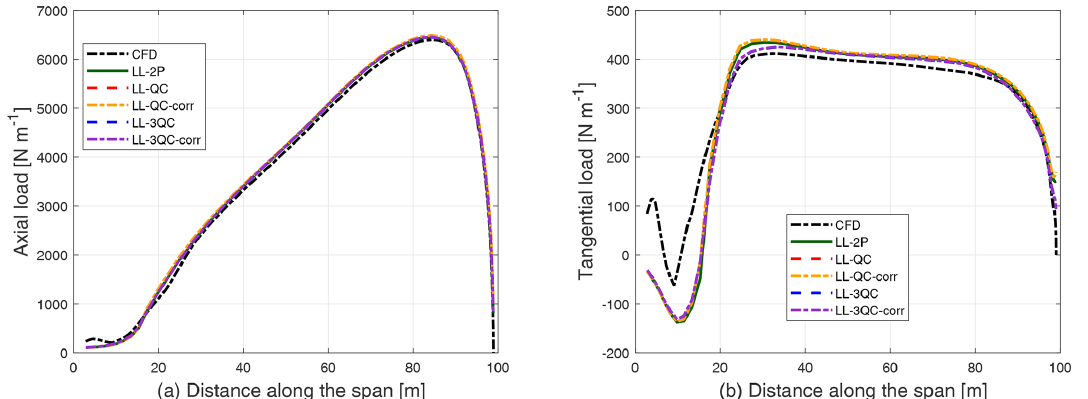
Figure 9. Comparison of axial load (a) and tangential load (b) of the straight blade without coning calculated from different LL methods and the fully resolved